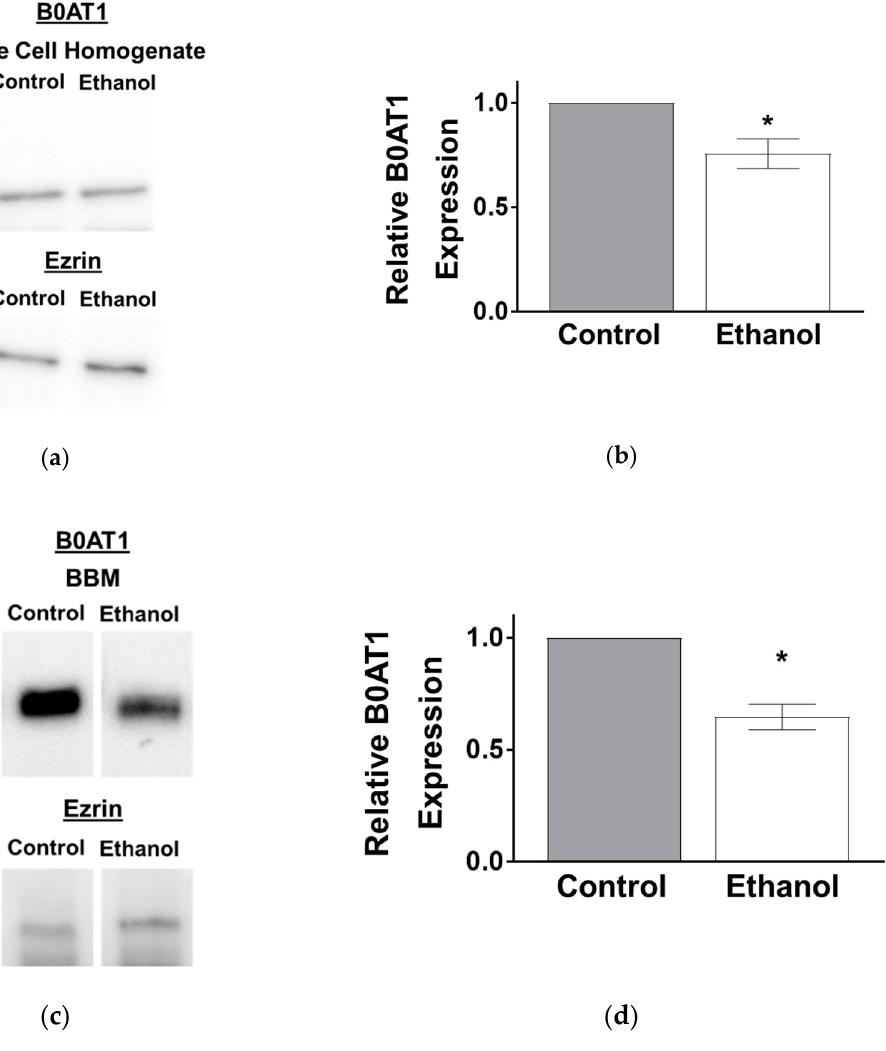
Figure 4. Moderate ethanol decreased the protein expression of B0AT1 in SD rats. ( a ) Western blot analysis of B0AT1 protein expression in whole cell homogenates from control and ethanol-treated rats. The blots show a representative sample used for densitometric quantification. ( b ) Densitometric quantification of B0AT1 protein expression was significantly decreased in whole cell homogenates after one-hour exposure of ethanol (* p < 0.01, n = 4). ( c ) Western blot analysis of BBM B0AT1 protein expression from control and ethanol-treated rats. The blots show a representative sample used for densitometric quantification. Each lane was located on the same membrane. ( d ) Densitometric analysis of B0AT1 protein expression was significantly decreased in the BBM fraction after one-hour exposure of ethanol (* p < 0.01, n = 4). The error bars represent the SEM. To assure equivalence of loading, the blots were normalized with anti-ezrin antibodies.